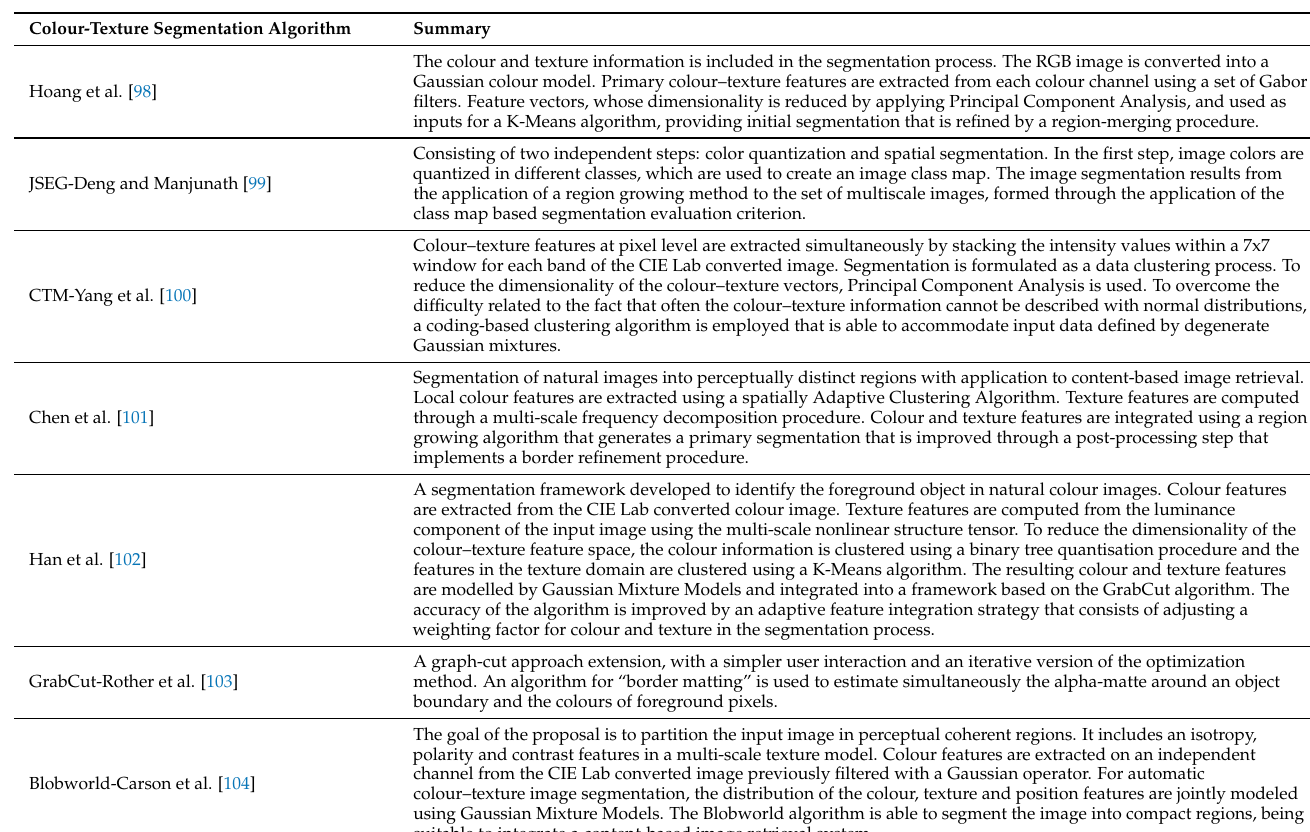
Table 2. Approaches proposed by other authors with which the results obtained by the proposed approach were